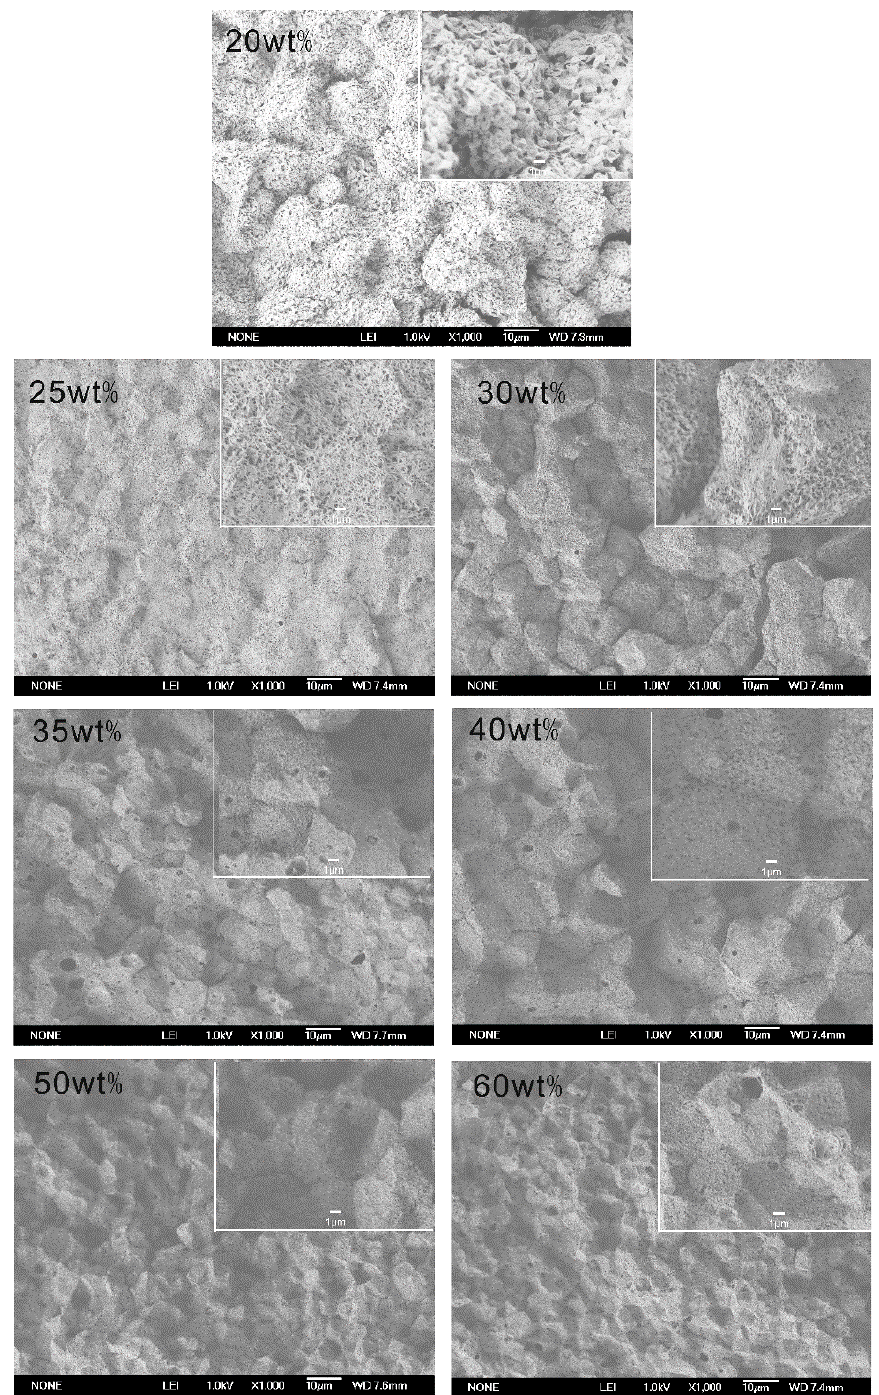
Figure 7. SEM micrographs of PVDF c1 membranes prepared from MS dilutions quenched in the ice water bath (the polymer content is marked in the upper left corner of each